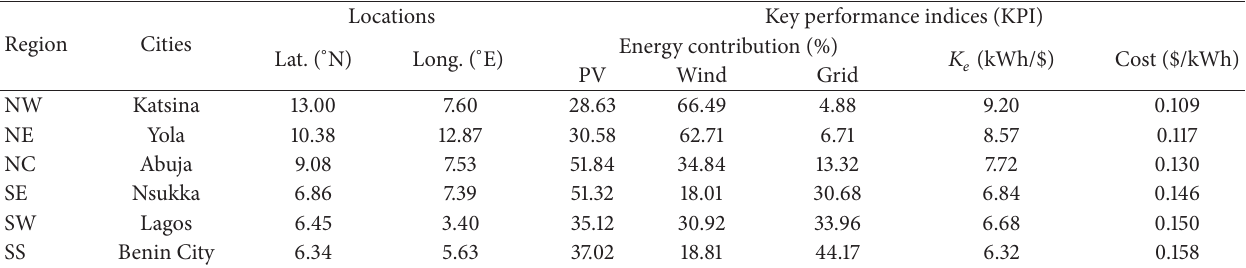
Table 1: Simulation results of the proposed system for studied locations.